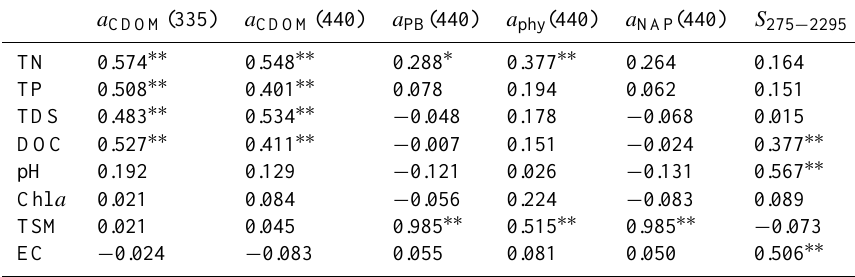
Table 3. Pearson correlation coefficients for general water quality and light absorption properties.